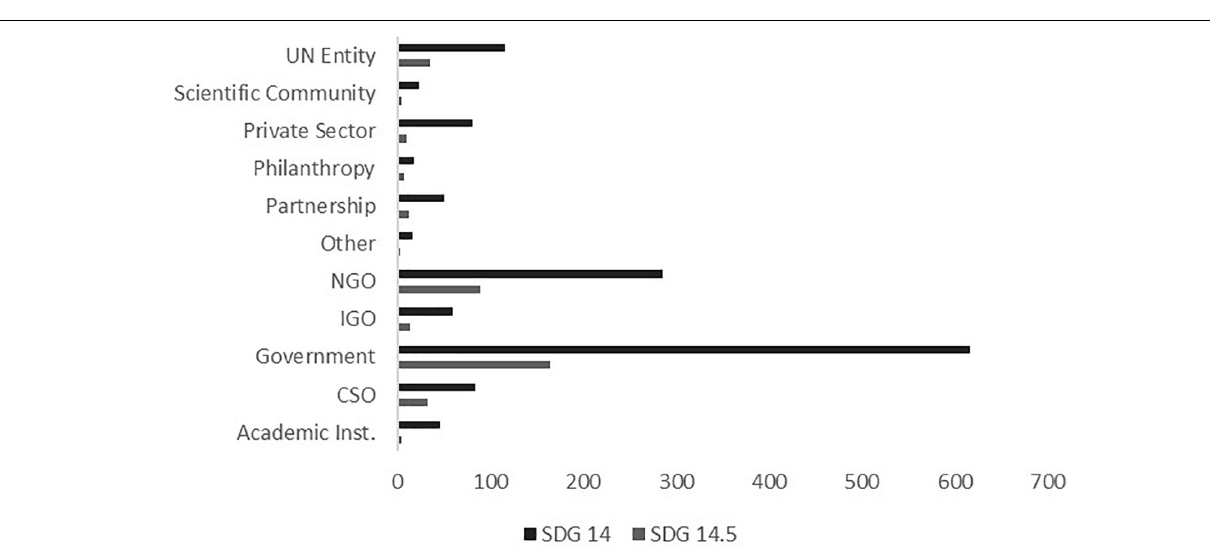
FIGURE 2 | Number of commitments made under SDG 14 and SDG 14.5. Sustainable development goal (SDG) 14 commitments ( N = 1,395) and SDG 14.5 commitments ( N = 376) sorted by entity who made the commitment. Data collected from https://oceanconference.un.org/commitments/ between June 2017 and September